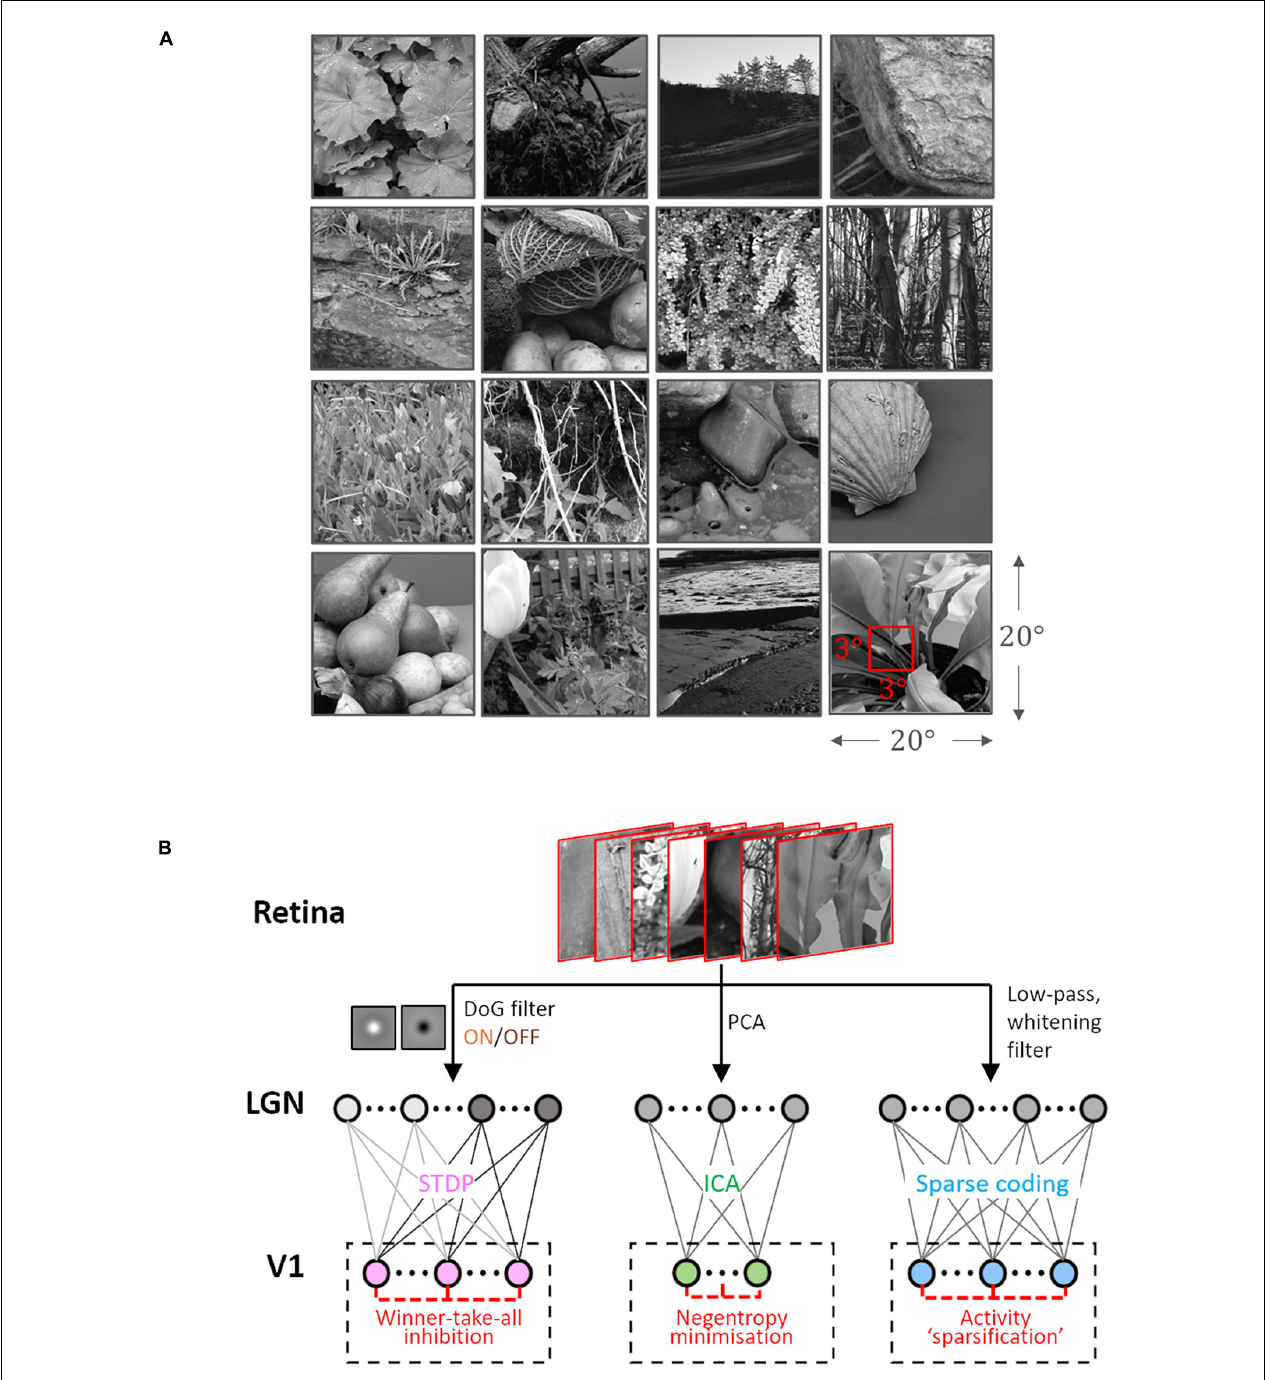
FIGURE 1 | Dataset and the computational pipeline. (A) Training data. The Hunter – Hibbard dataset of natural images was used. The images in the database have a 20 ◦ × 20 ◦ field of view. Patches of size 3 ◦ × 3 ◦ were sampled from random locations in the images (overlap allowed). The same set of 100,000 randomly sampled patches was used to train three models: Spike-timing dependent plasticity (STDP), Independent Component Analysis (ICA), and Sparse Coding (SC). (B) Modelling the early visual pathway. Three representative stages of early visual computation were captured by the models: retinal input, processing in the lateral geniculate nucleus (LGN), and the activity of early cortical populations in the primary visual cortex (V1). Each input patch represented a retinal input. This was followed by filtering operations generally associated with the LGN, such as decorrelation and whitening. Finally, the output from the LGN units/filters was connected to the V1 population through all-to-all (dense) plastic synapses which changed their weights during learning. Each model had a specific optimisation strategy for learning: the STDP model relied on a local rank-based Hebbian rule, ICA minimised mutual information (approximated by the negentropy), and SC enforced sparsity constraints on V1 activity. DoG, difference of Gaussian; PCA, Principal Component